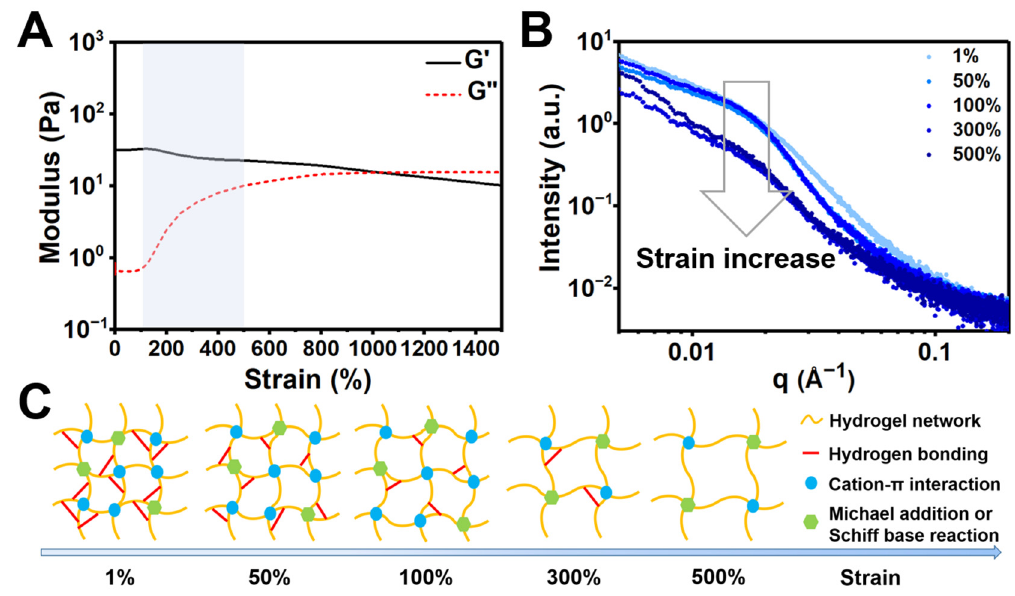
Figure 5. Strain-dependent and in situ SAXS for the CC hydrogel at 25 °C (solid content 1.5%). ( A ) The G ′ and G ′′ values by strain sweep from 0.1% to 1500% dynamic strain at the frequency of 1 Hz. ( B ) In situ SAXS profiles of the hydrogel upon increasing strains. ( C ) A scheme for the possible network changes in the CC hydrogel as the strain increases.